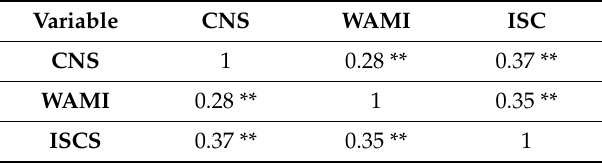
Table 2. Full correlation matrix between connectedness to nature (CNS), the work and meaning inventory (WAMI), and the intrapreneurial self-capital scale (ISCS).